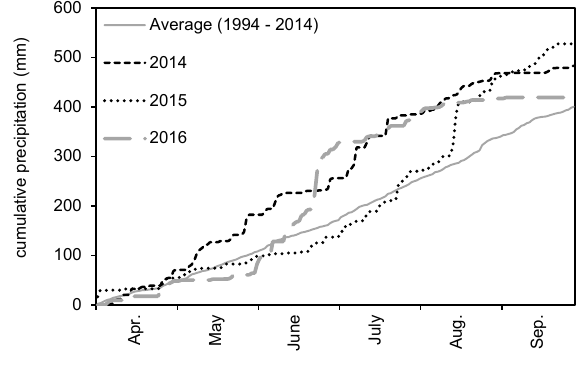
Figure 2 : Cumulative precipitation (mm) from April to September at the Hollage experiment. Comparing long average (1994–2014) with 2014, 2015 and 2016 growing